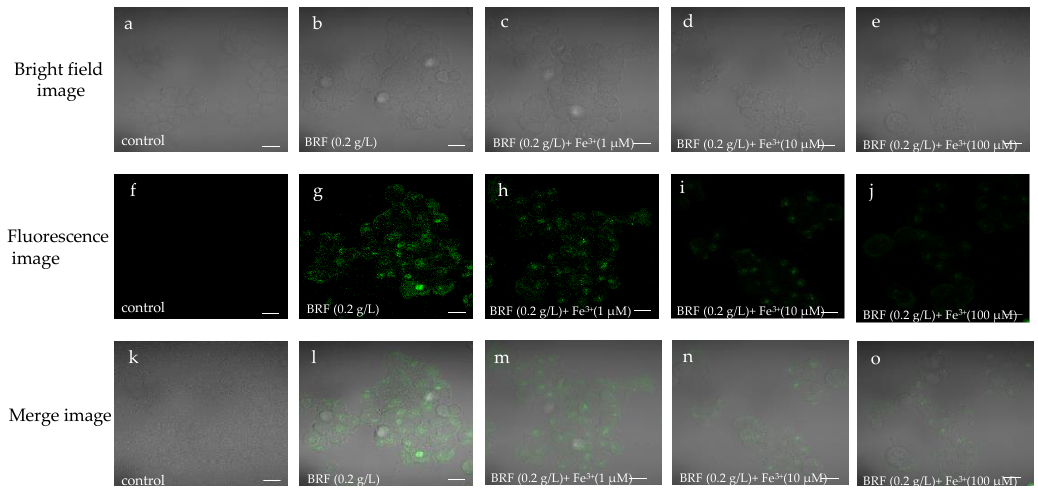
Figure 5. Confocal images of L02 cells. ( a )–( e ): bright field images; ( f )–( j ): fluorescence images; ( k )–( o ): merge images.